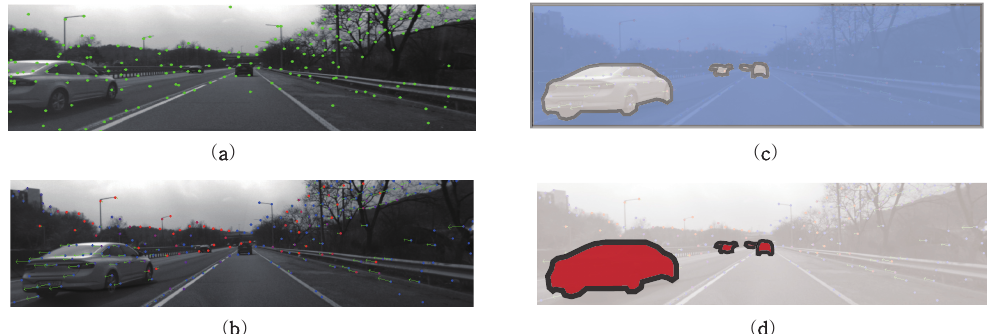
Figure 10. Disturbances on optical flow with moving traffics. ( a ) Matched Feature, ( b ) Optical Flow, ( c ) Static Scene, ( d ) Moving Scene.